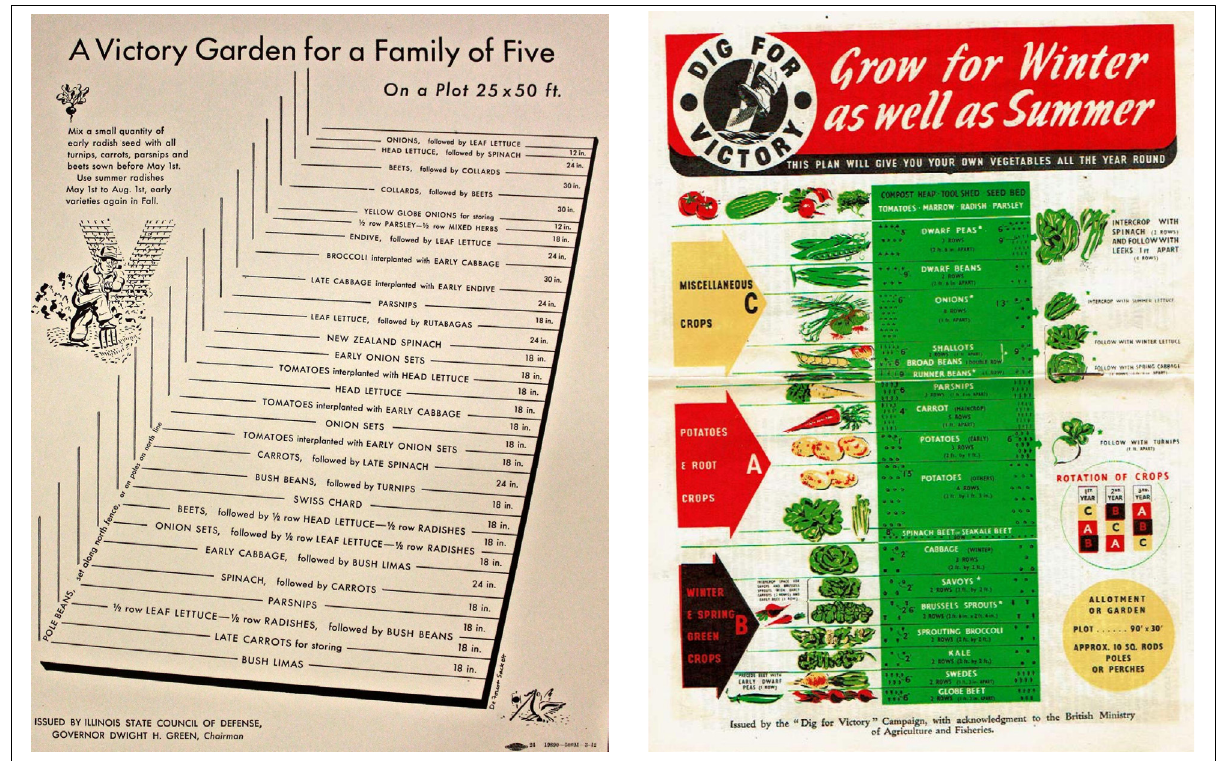
Figure 1: Plan for a ‘Victory’ or ‘War’ garden disseminated to the American public in 1914 1 judged to be a successful programme (left), and a schematic disseminated to gardeners in the British ‘Dig for Victory’ campaign 48 deemed to be over-complicated and less successful